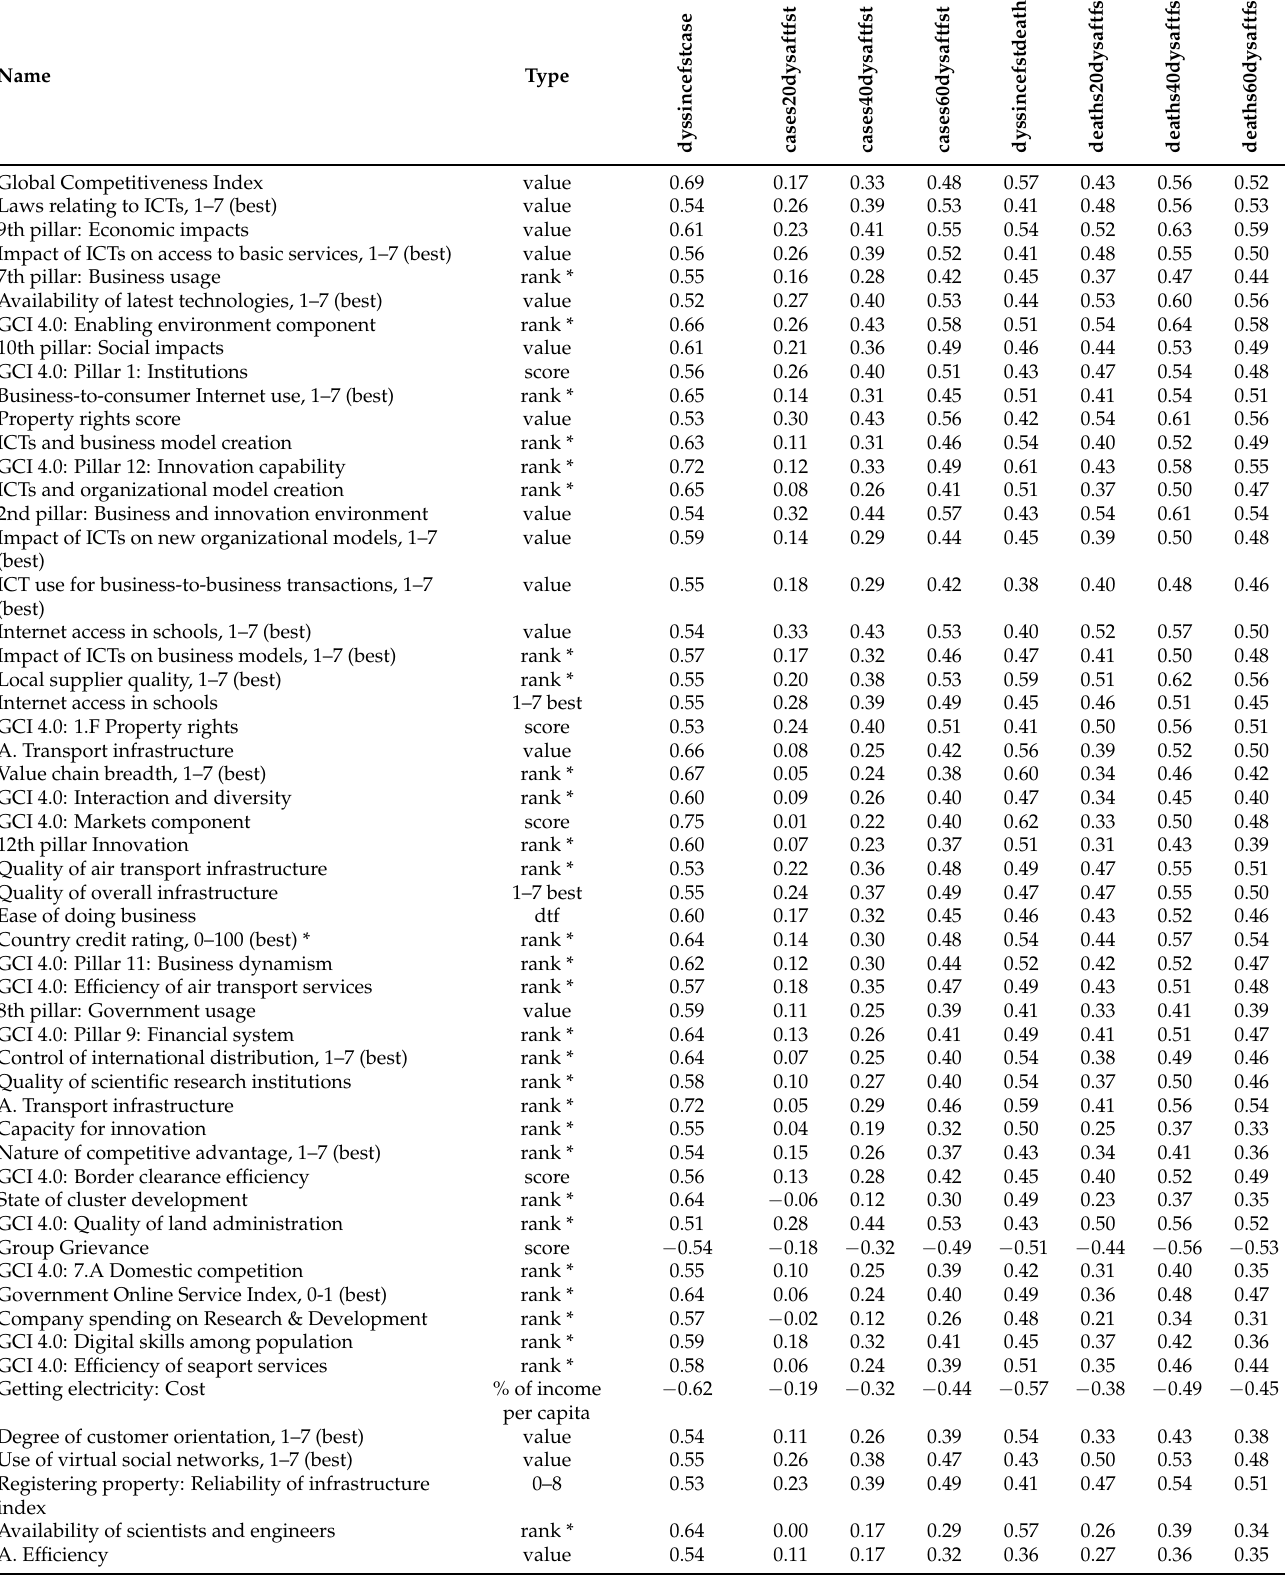
Table A3. Standalone correlations in the business and ICT community. Spearman rank correlations between COVID-19 variables and indicators of the business and ICT community in the worldwide